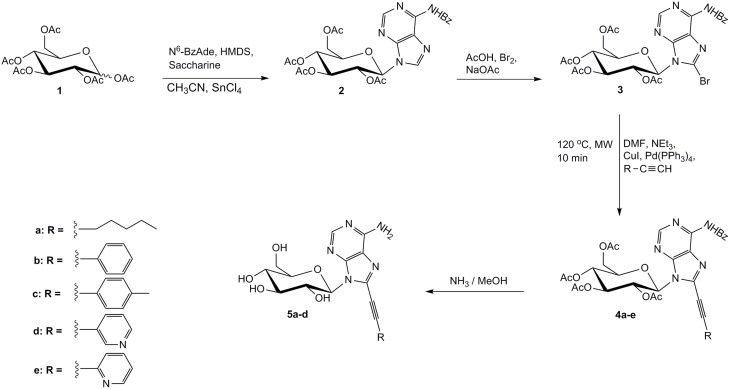
Synthesis of C8-alkynyl adenine glucopyranonucleosides.